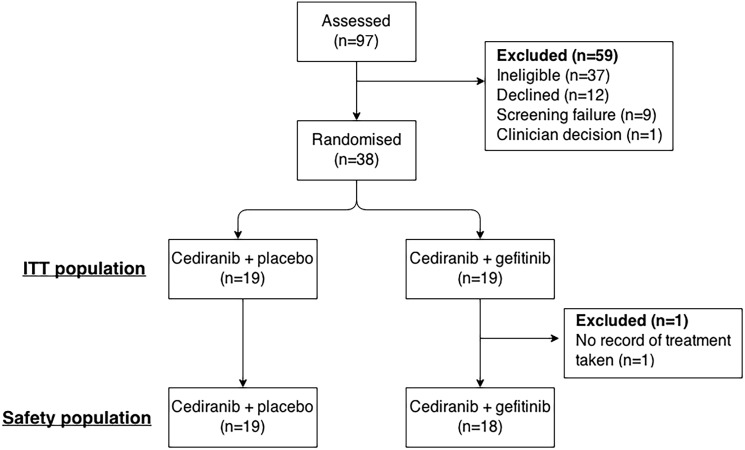
CONSORT diagram.